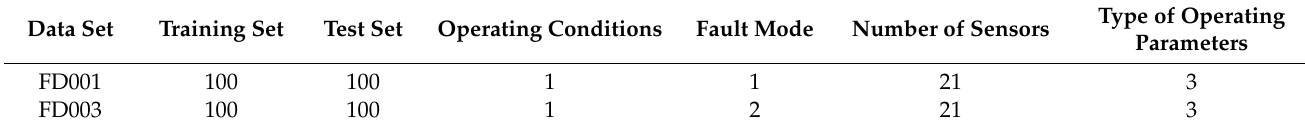
Table 3. Data sets FD001 and FD003 are